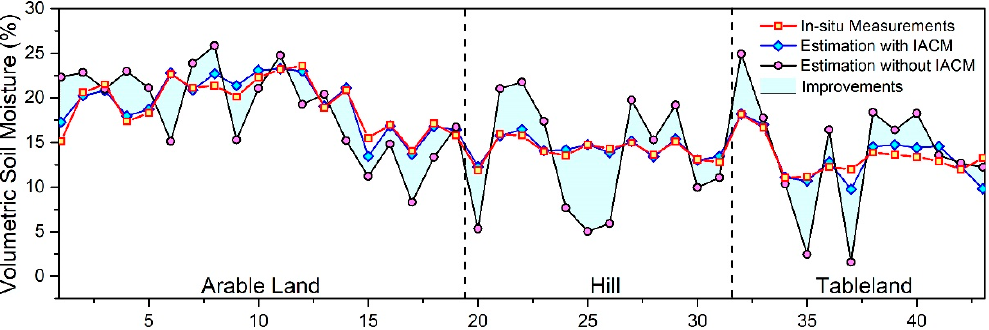
Figure 13. The volumetric soil moisture in each in situ site by different methods under various topographical conditions.